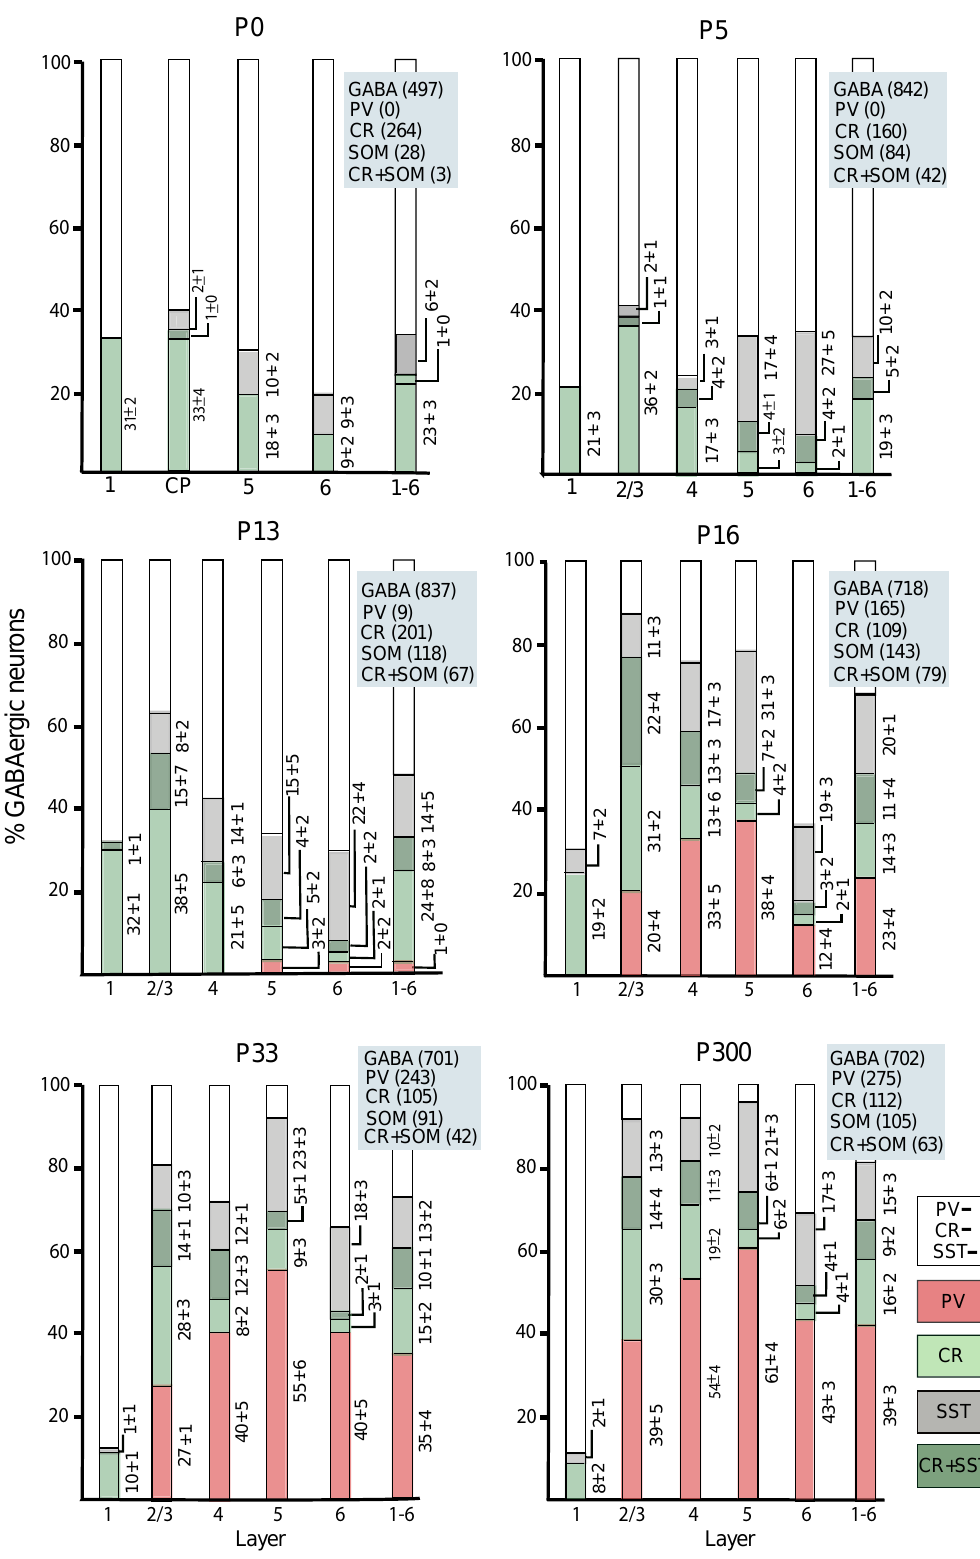
Figure 7. Percentage of PV, CR, SOM and CR ++ SOM neurons in population of GABAergic neurons across postnatal development of mouse visual cortex. Columns represent percentages of CR, SOM, PV and CR + SOM immunolabeled neurons in the total population of GABAergic neurons in different layers and at different postnatal ages. Numbers represent mean ± SEM percentages of each cell type in the population of GABAergic neurons across different sections and animals. The blue boxes contain the total number of cells counted for each marker. CP: cortical